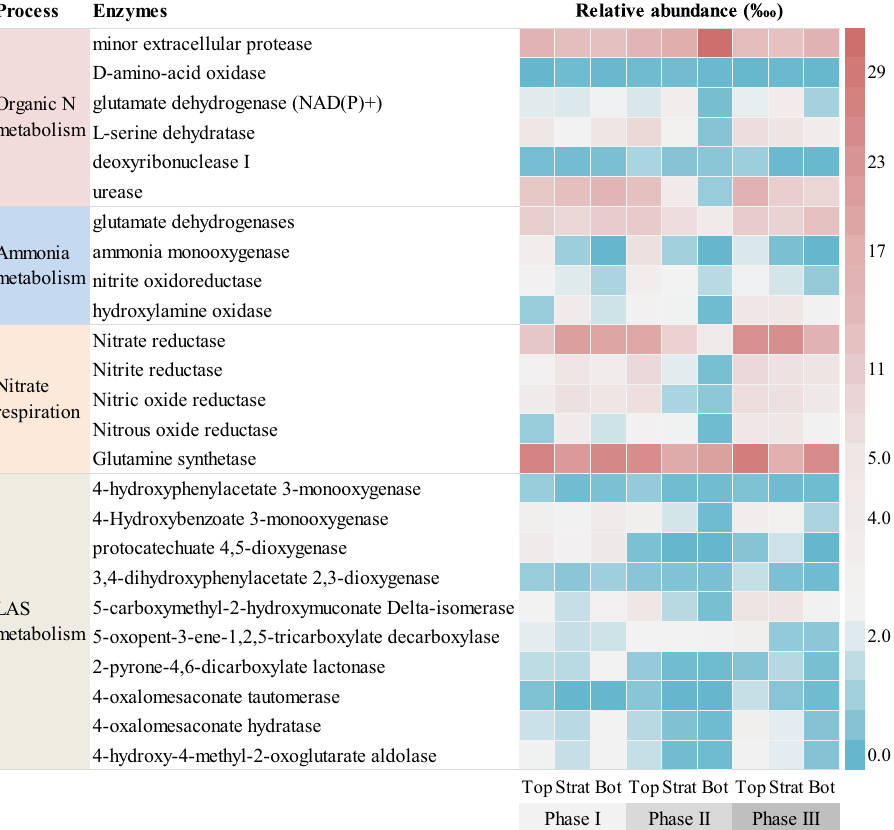
Fig. 5 Dynamics of functional enzymes. Relative abundance of predicted functional enzymes involved in several key metabolisms by PICRUSt analysis in the bio fi lms of the bio-enhanced granular-activated carbon dynamic bio fi lm reactor (BhGAC-DBfR) at various saturated/ unsaturated ratios during graywater